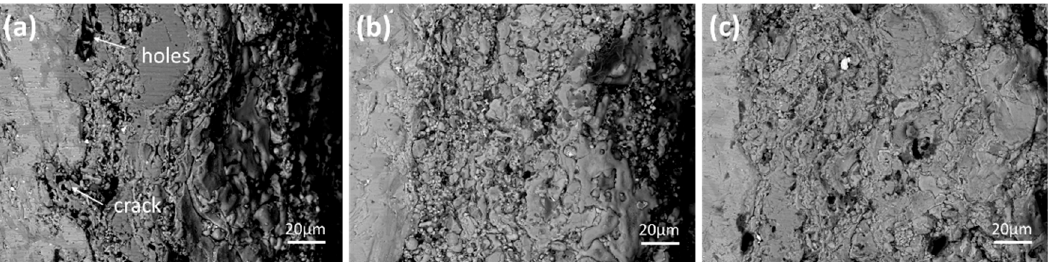
Figure 3. Cross-section morphology of MoSi 2 -ZrB 2 coatings: ( a ) mz40, ( b ) mz43 and ( c ) mz45. Table 2. The EDS results of constituent phase of mz45 sample (at.%).